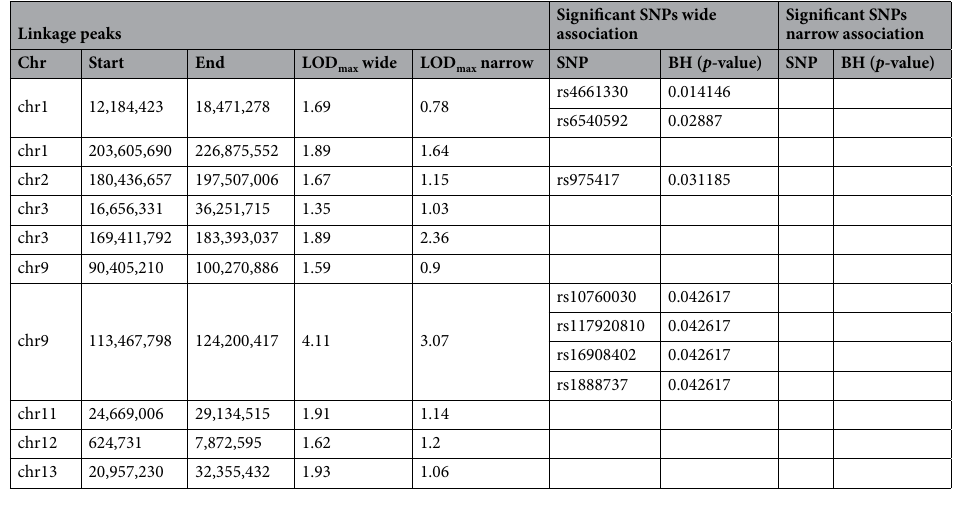
Table 1. Results of the NPL analysis and association analysis. The coordinates within each chromosome (chr) are based on the human genome reference CRGh37/hg19. p -values are adjusted by Benjamin–Hochberg